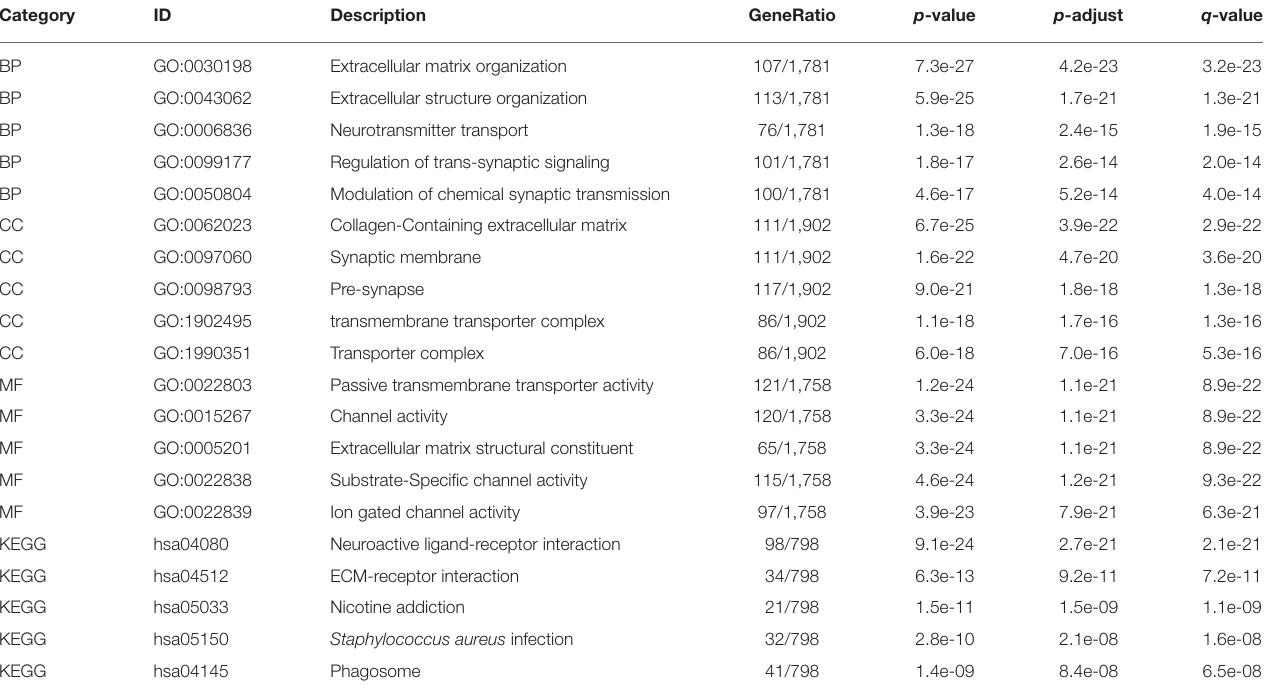
TABLE 4 | GO/KEGG enrichment analysis of REST-associated DE-mRNAs.